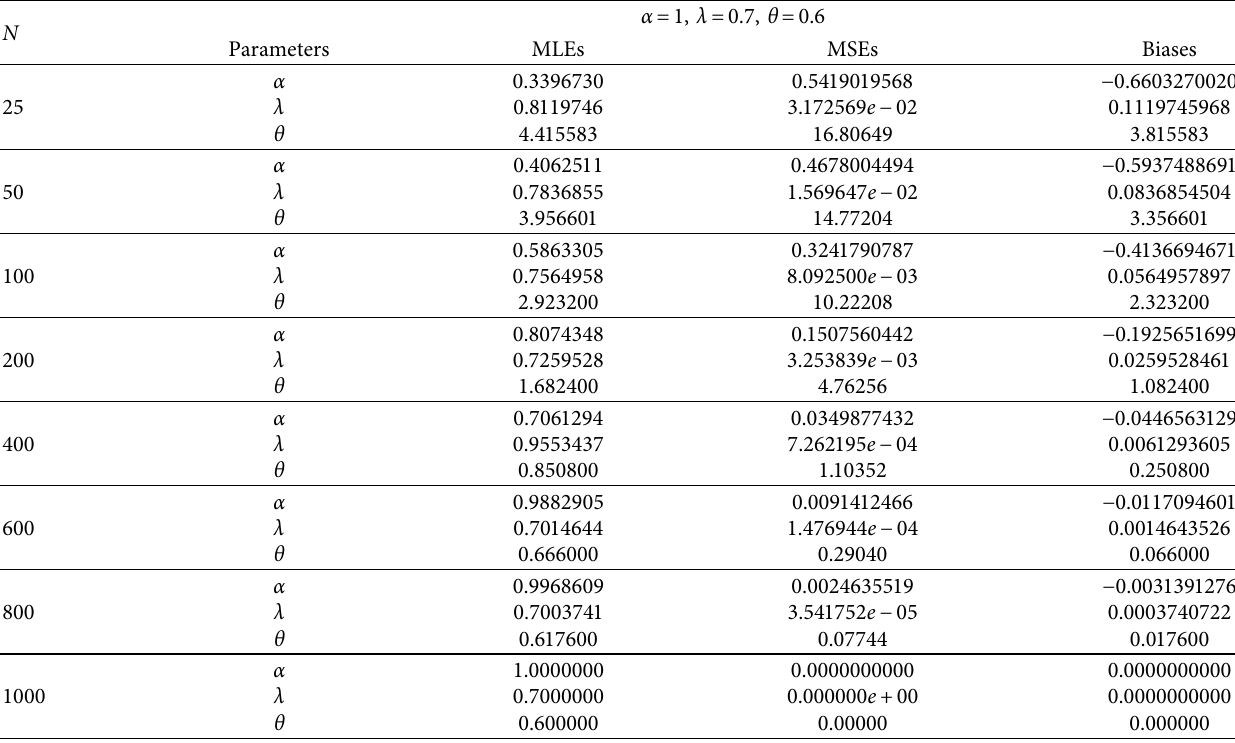
Table 2: The numerical results of the MLEs, MSEs, and biases for the NEE-W model using different values of parameters.